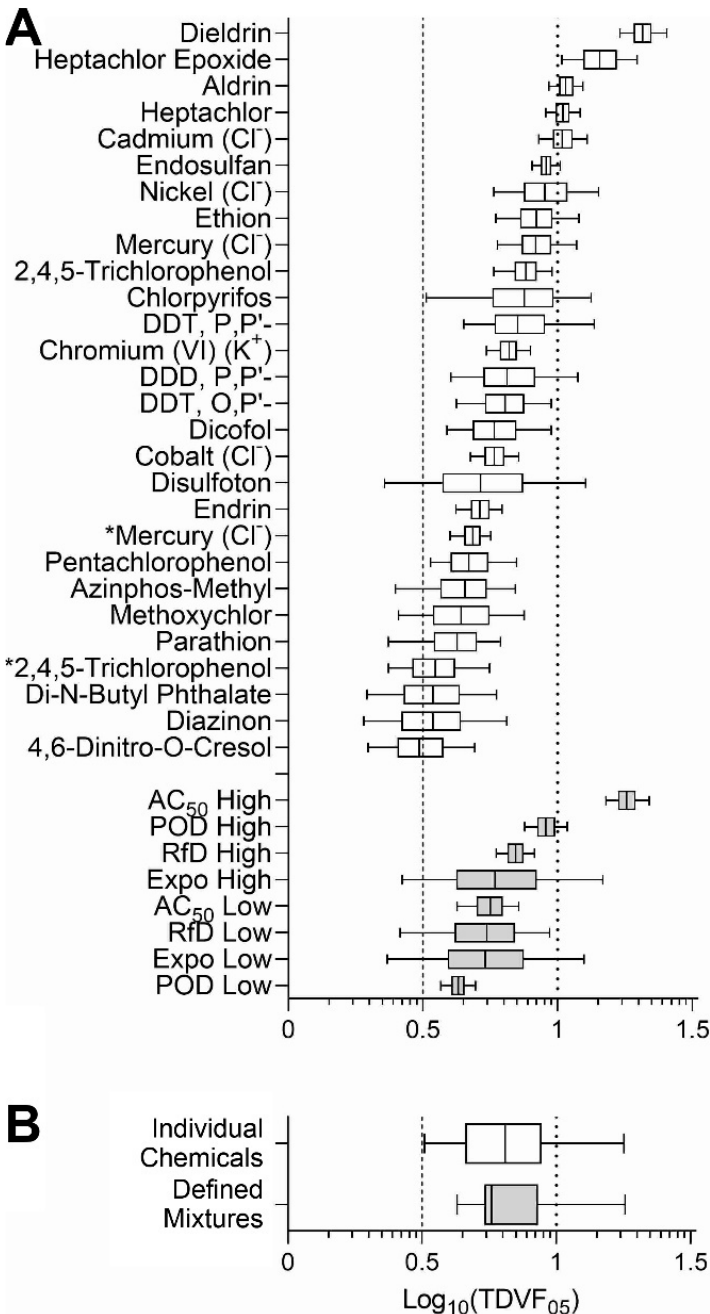
Figure 6. Distribution of TDVF 05 for chemicals and mixtures across all cell lines. ( A ) Distribution of TDVF 05 values for individual chemicals and mixtures is shown as box (interquartile range)-and-whiskers (5th and 95th percentiles) plots. Asterisks (*) denote compounds that were technical on-plate replicates. ( B ) Overall distribution of the TDVF 05 for chemicals and mixtures. The vertical dashed line represents the default toxicodynamic variability factor of 10 1/2 and the vertical dotted line represents a default total variability factor of 10.